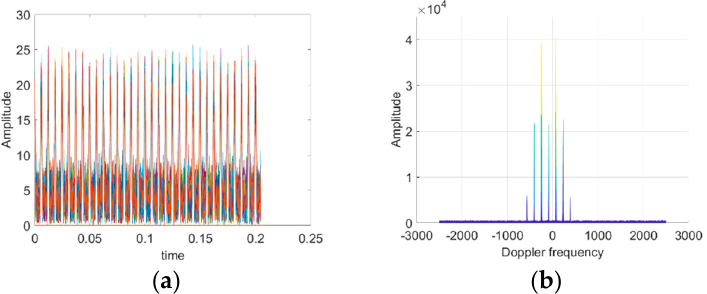
Figure 3. Simulation results of the ideal mathematical model of the single rotary-wing. ( a ) Time domain modulated echo. ( b ) Doppler domain modulation spectrum.